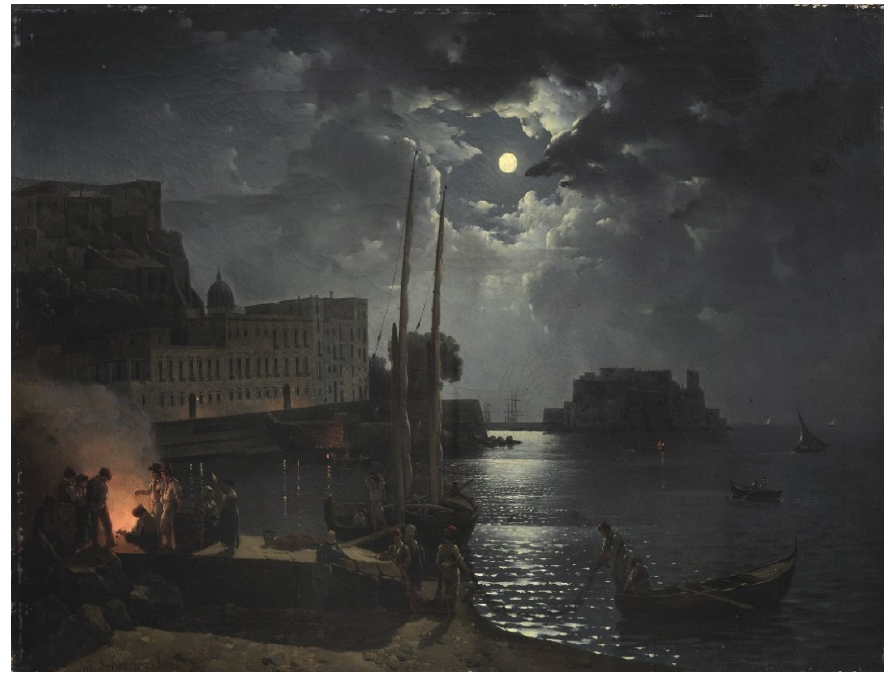
Figure 26. Sylvester Shchedrin. Moonlit Night in Naples , 1828. State Tretyakov Gallery, Moscow.